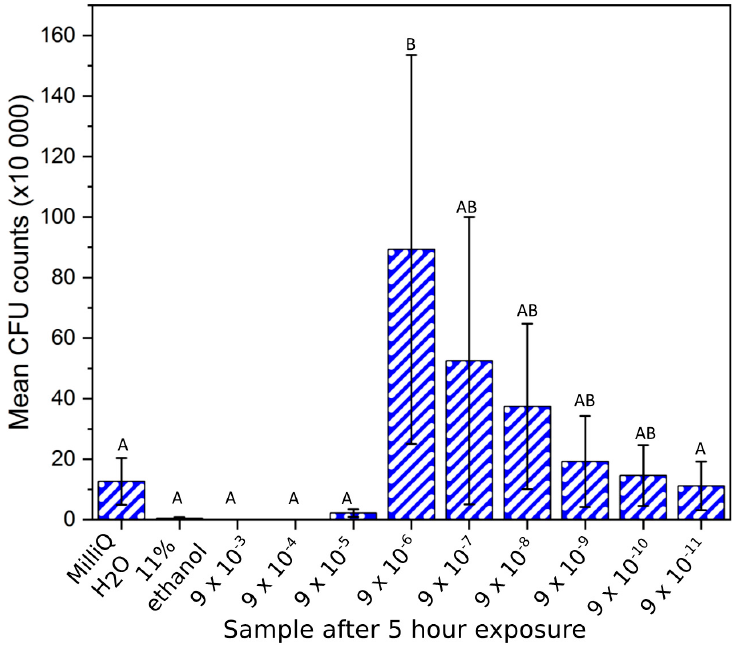
Figure 3. Colony-forming unit (CFU) counts (mean ± SD) of XEN43 bacteria after 5 h for all sample solutions, the negative (MilliQ) and positive (11% ethanol) controls. Brown–Forsythe: F (1, 10) = 1.78, p = 0.125. One-way ANOVA: F = 3.39 ( p = 0.008). Note: Samples indicated with the same letter are non-significantly different, e.g., “A” denotes that samples indicated with “A” are non-significantly different ( p > 0.05). This also applies to samples indicated with “B. In addition, e.g., “AB” denotes non-significantly different to samples indicated with “A” and “B”. Conversely, samples indicated with differing letters, denotes statistically significantly different ( p < 0.05).